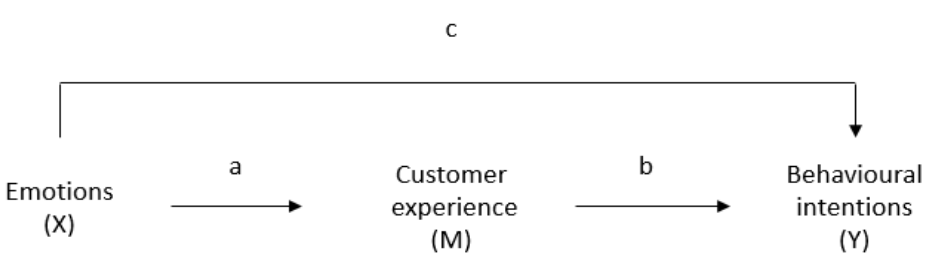
Figure 1. The examined mediating effect depiction.